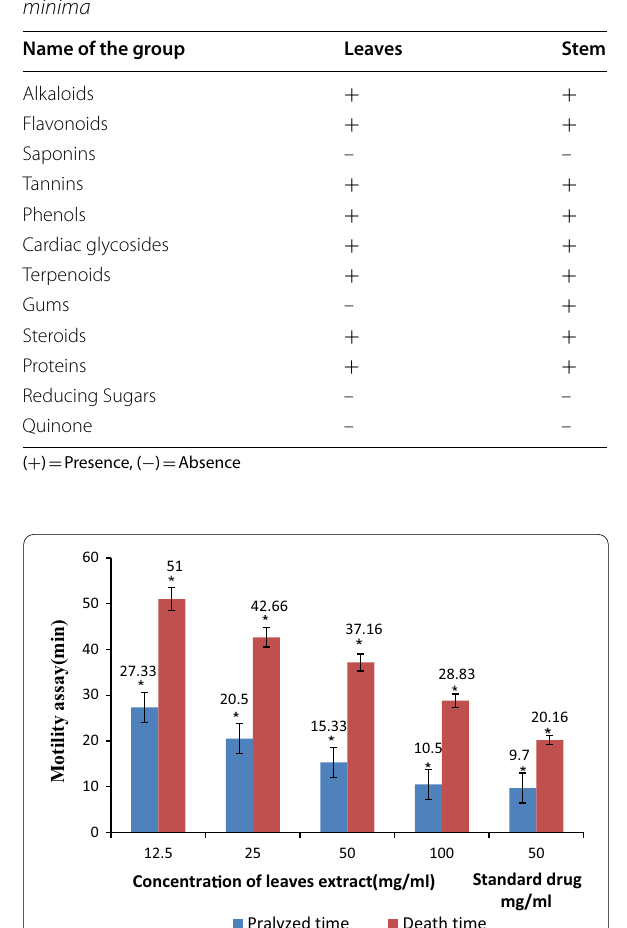
Fig. 1 Graphical presentation for anthelmintic activity of P. minima leaves on the basis of paralysis time and death time on P. cervi in different concentration and it was compared with standard drug Albendazole. Less time was required for leaves to cause paralysis and death (10.5 min and 28.83 min) of worms by an ethanolic extract (100 mg/ml). Data are expressed in mean SEM (* p < 0.05) ±